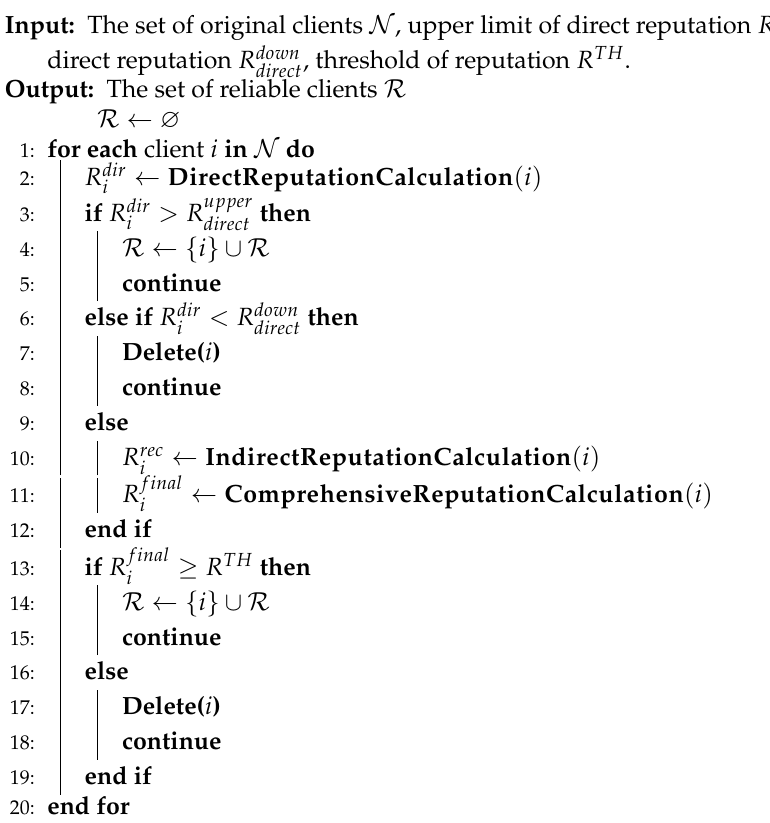
Algorithm 1 Reliable client-selection